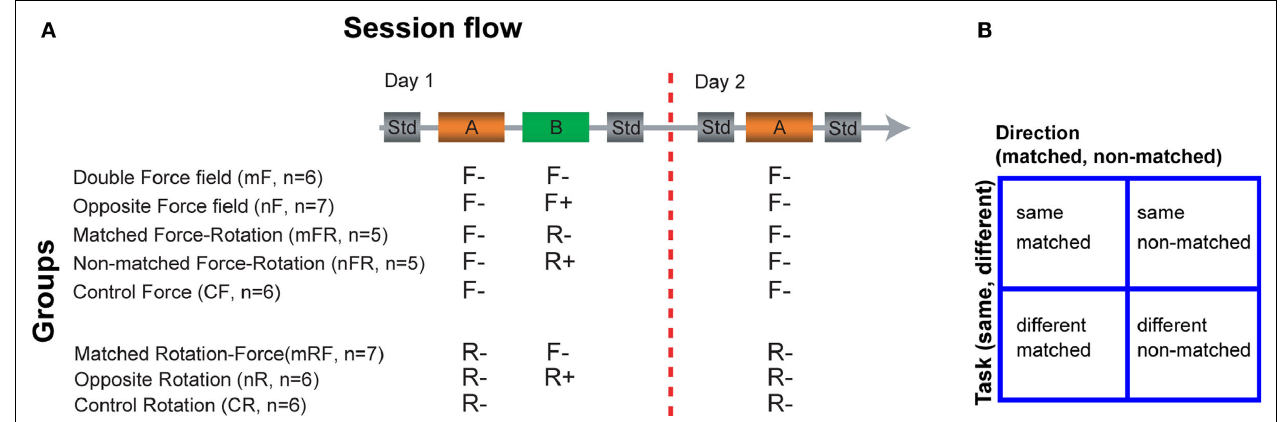
below the boxes corresponding to tasks A and B) were either force fi eld (F) or visuomotor rotation (R) of matched (m) or non-matched (n) direction. The signs correspond to clockwise ( + ) and counter-clockwise ( − ) directions. Abbreviations of the group names and the number of subjects in each group are enclosed in parenthesis. (B) Illustration of combinations of task and direction